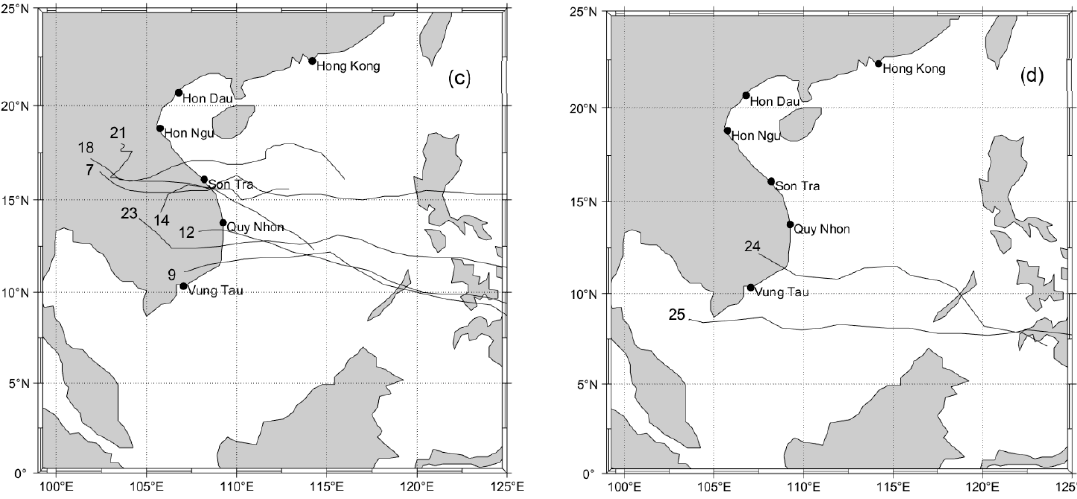
Figure 3. Tracks of typhoons that made landfall on the Vietnam coast from 2013 to 2017: ( a ) all tracks; ( b ) typhoons making landfall on the Northern coast; ( c ) typhoons making landfall on the Central coast; ( d ) typhoons making landfall on the South coast. Key to the numbers referring to typhoons: 1–TS Bebinca (June-13), 2–STS Rumbia (June-13), 3–STS Jebi (August-13), 4–TS Mangkhut (August-13), 5–TY